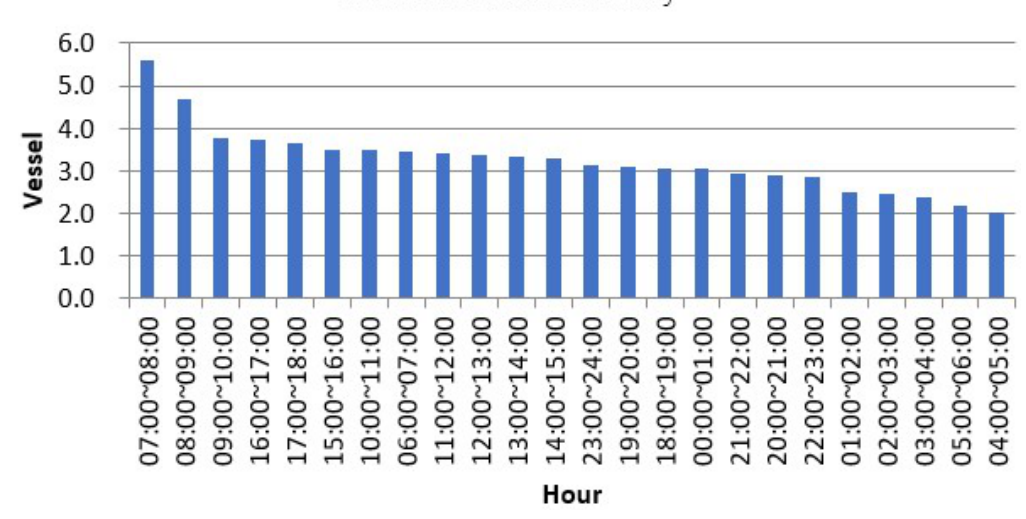
Figure 3. The daily traffic flow of vessels entering/exiting the Kaohsiung port.